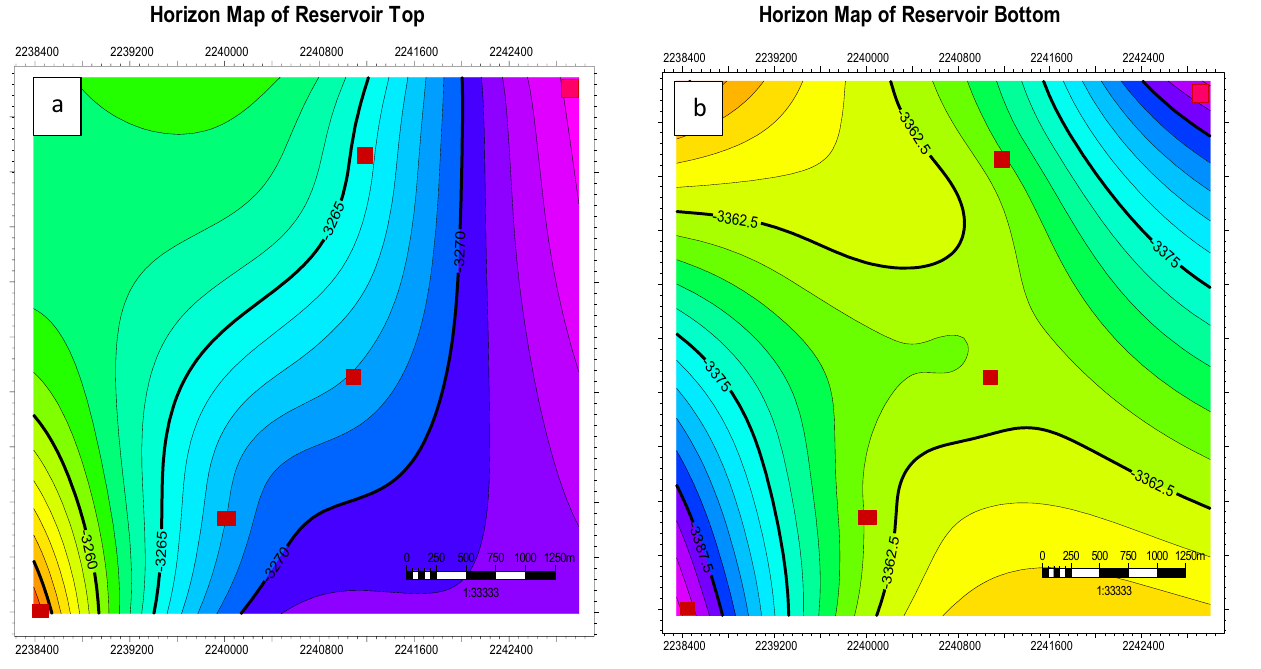
Fig. 5 Upper horizon map (left) and lower horizon map (right) of the studied